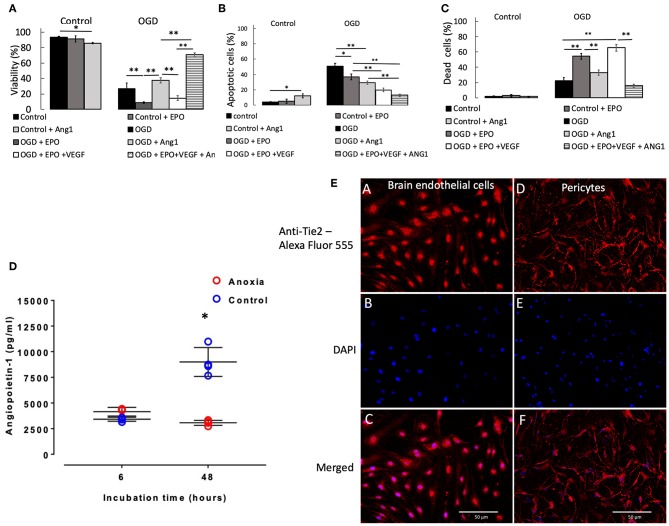
Percentage of pericytes that were viable (A), apoptotic (B), and dead (C), respectively after 24 h control or OGD protocols. Data were presented as mean ± SD, n = 4–8. Symbols indicate: *p < 0.05, **p < 0.01. (D) Angiopoietin-1 secretion by pericytes in culture during anoxia and control conditions. Values from each sample are presented as separate points. In some cases, data overlap and hence may appear to be <4 samples. The mean of the four values and SD were calculated; the latter ones being presented with solid lines. In some cases, SDs were marginal, so they appear as a single line. Symbol [*] indicates that values in anoxic groups were lower (p < 0.05) vs. values during normoxia (control). (E) Staining of rat primary brain endothelial cells (left column of images, A–C) and rat primary pericytes (right column of images, D,E) for Tie2 receptor. (A,D) Anti-Tie2 receptor staining, labeled with Alexa Fluor 555; (B,E) DAPI stain; (C,F) overlay of anti-Tie2 receptor and DAPI staining.